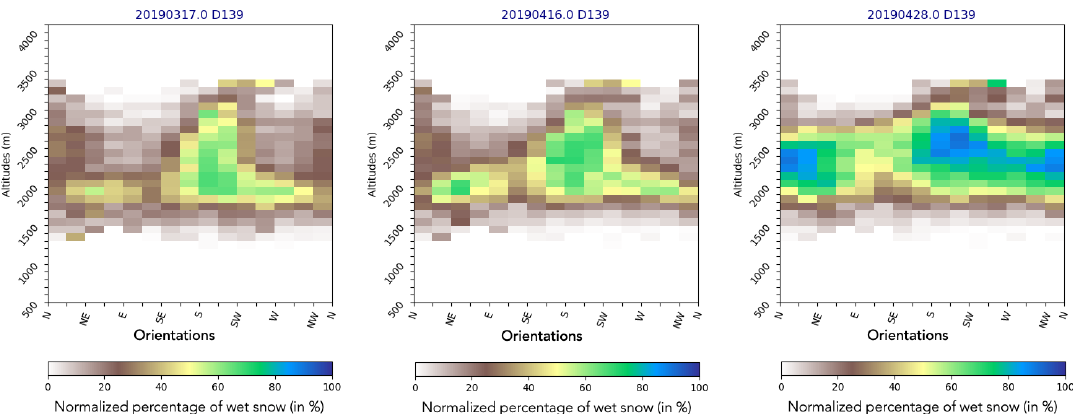
Figure 11. Same as Figure 9 but for spring 2019: 17 March 2019, 16 April 2019 and 28 April 2019.